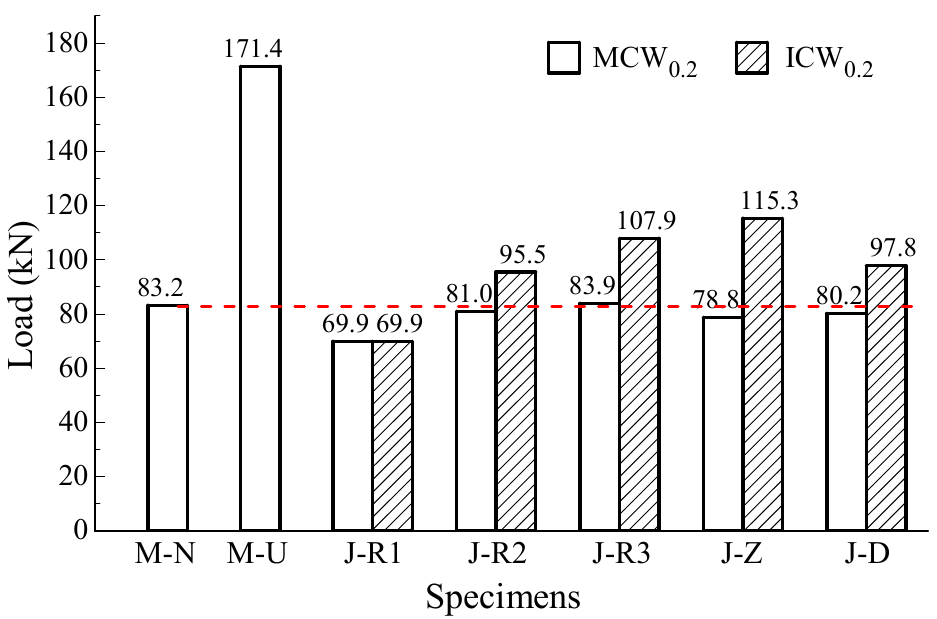
Figure 6. Loads corresponding to crack width of 0.2 mm.